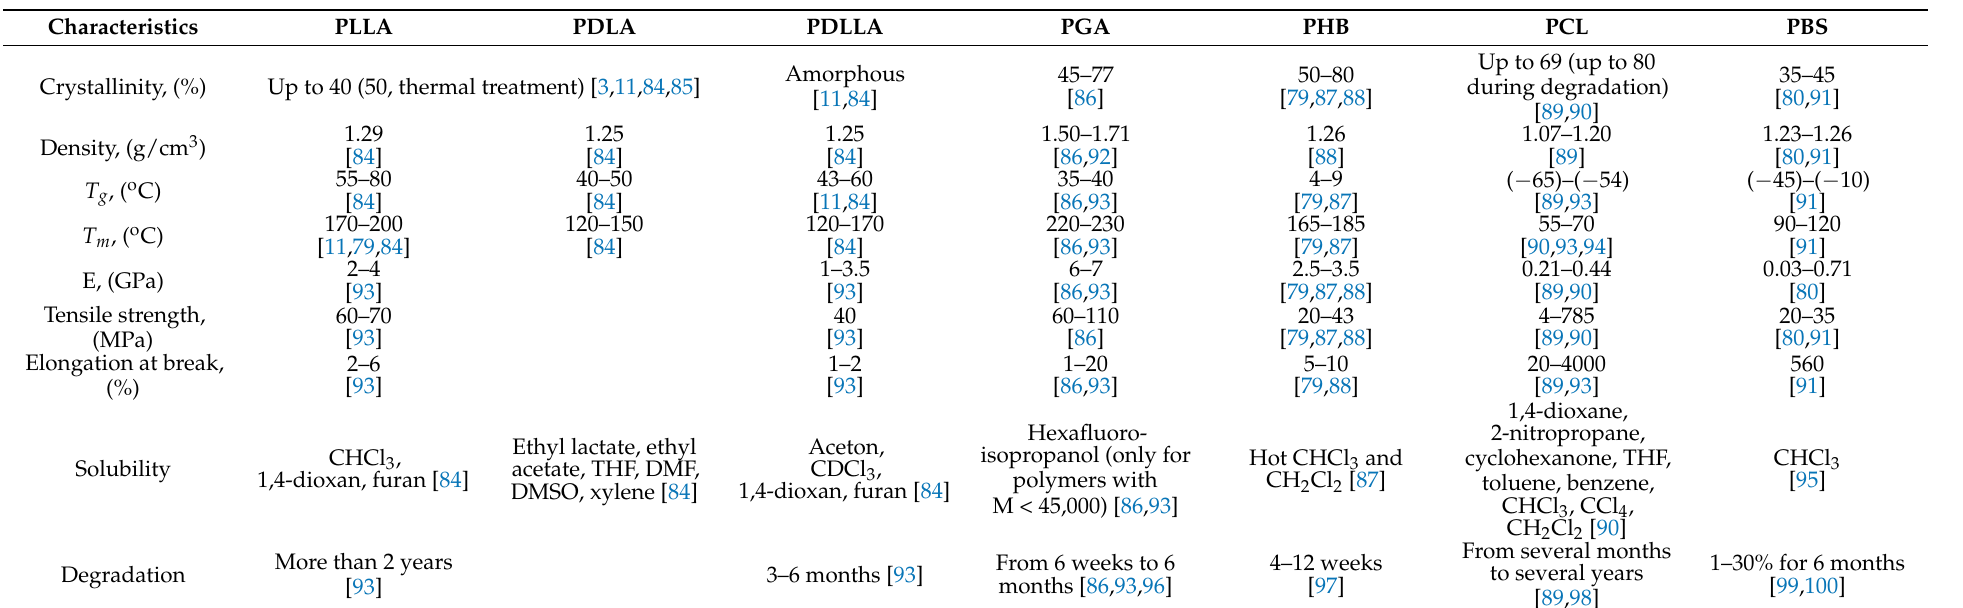
Table 2. Some characteristics of commonly used aliphatic